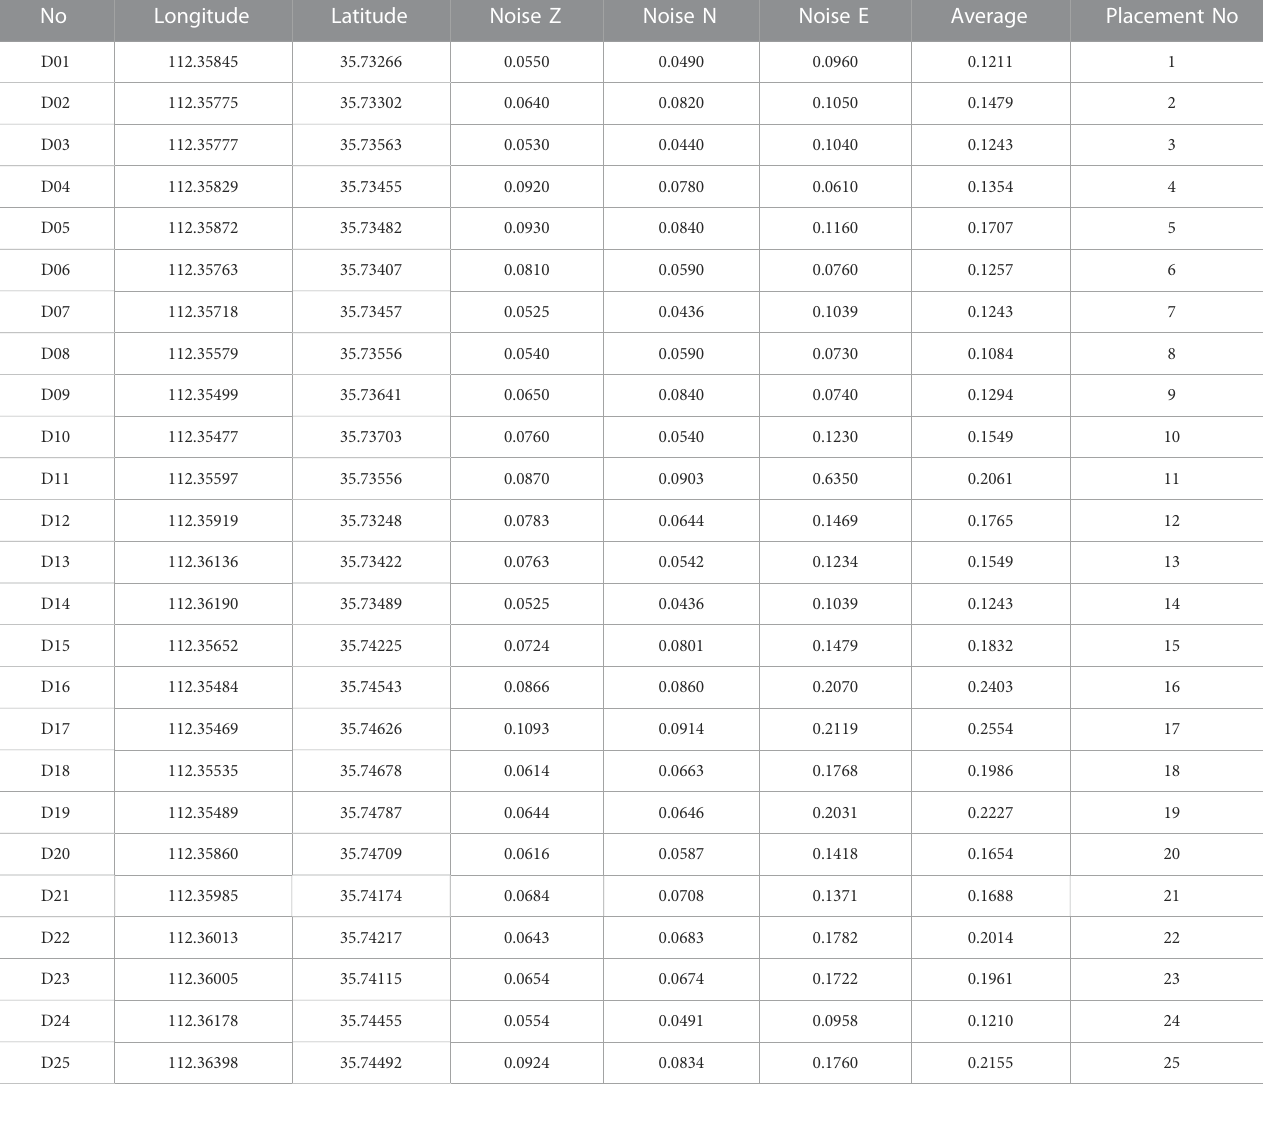
TABLE 2 Background noise of fracturing monitoring seismic station of Well ZHSY-1. No Longitude Latitude Noise Z Noise N Noise E Average Placement No